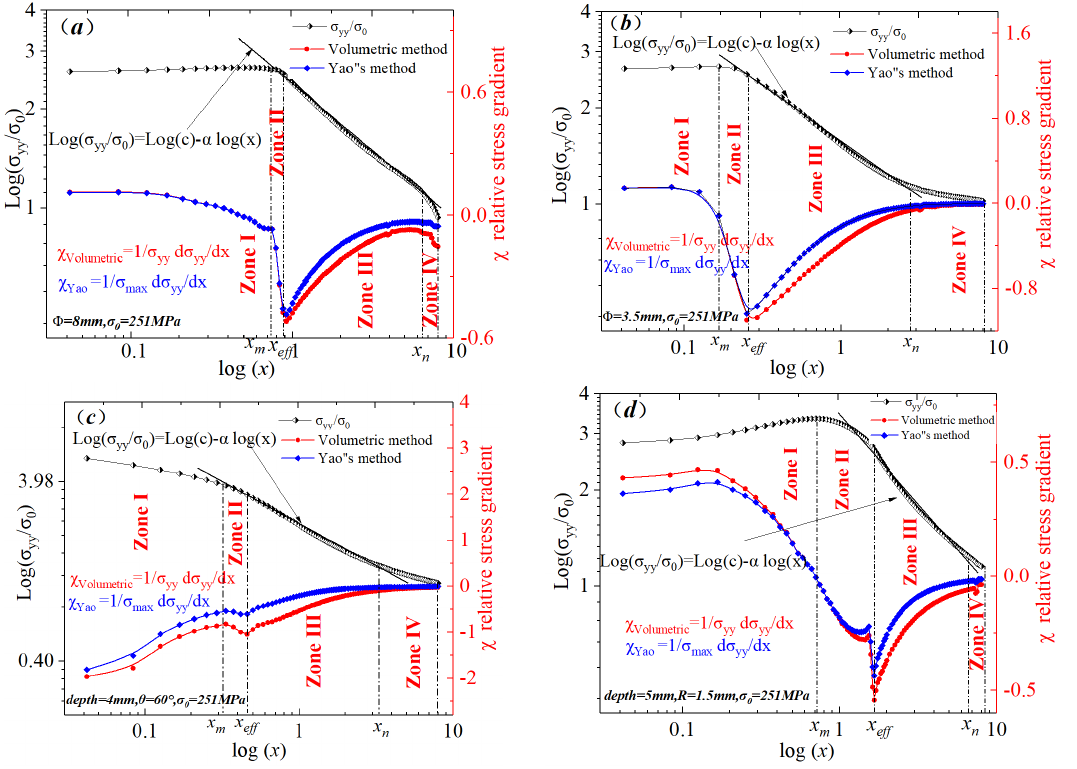
Figure 6. Bi-logarithmic diagrams for elastic–plastic stress distributions at the notch bisector of dif- ferent specimens. ( a ) big circle hole plate, ( b ) little circle hole plate, ( c ) sharp V-notch plate, ( d ) U-notch plate.